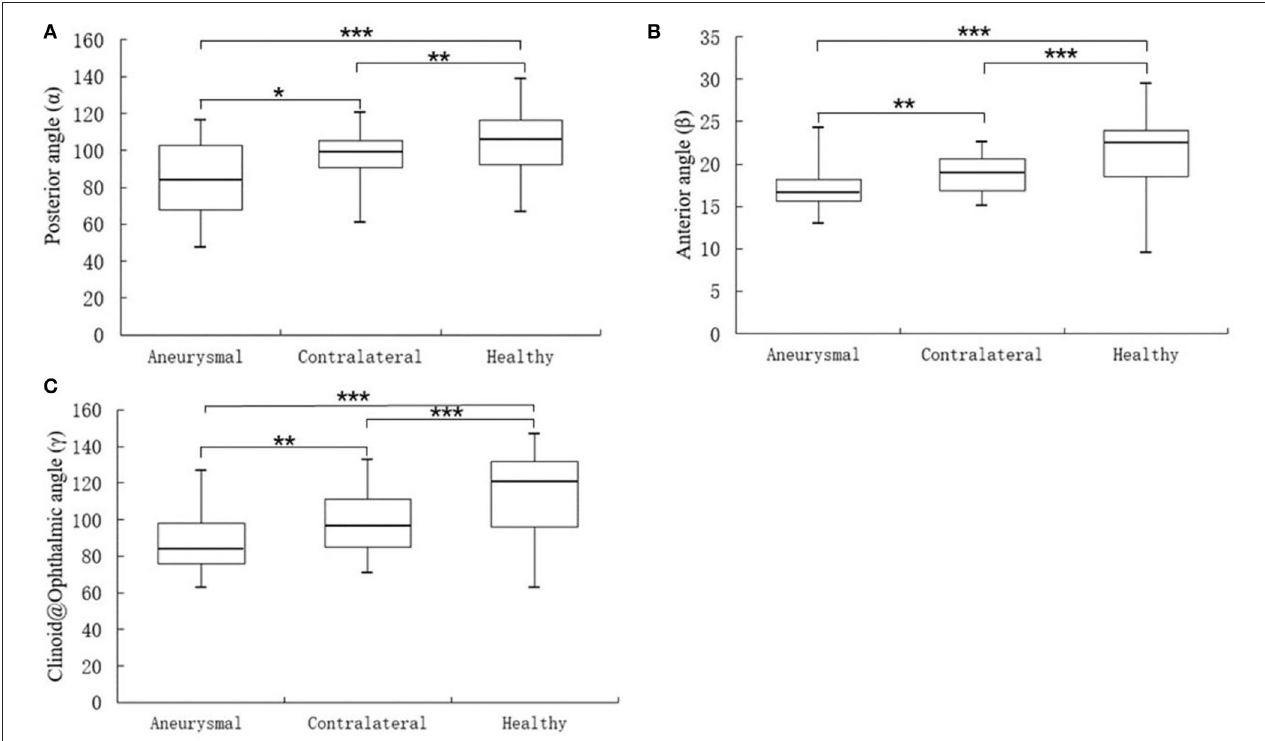
FIGURE 4 | Statistical differences between aneurysmal, contralateral, and healthy carotid siphon angle for angles α (A) , β (B) , and γ (C) . * P < 0.05, ** P < 0.01, *** P < 0.001.